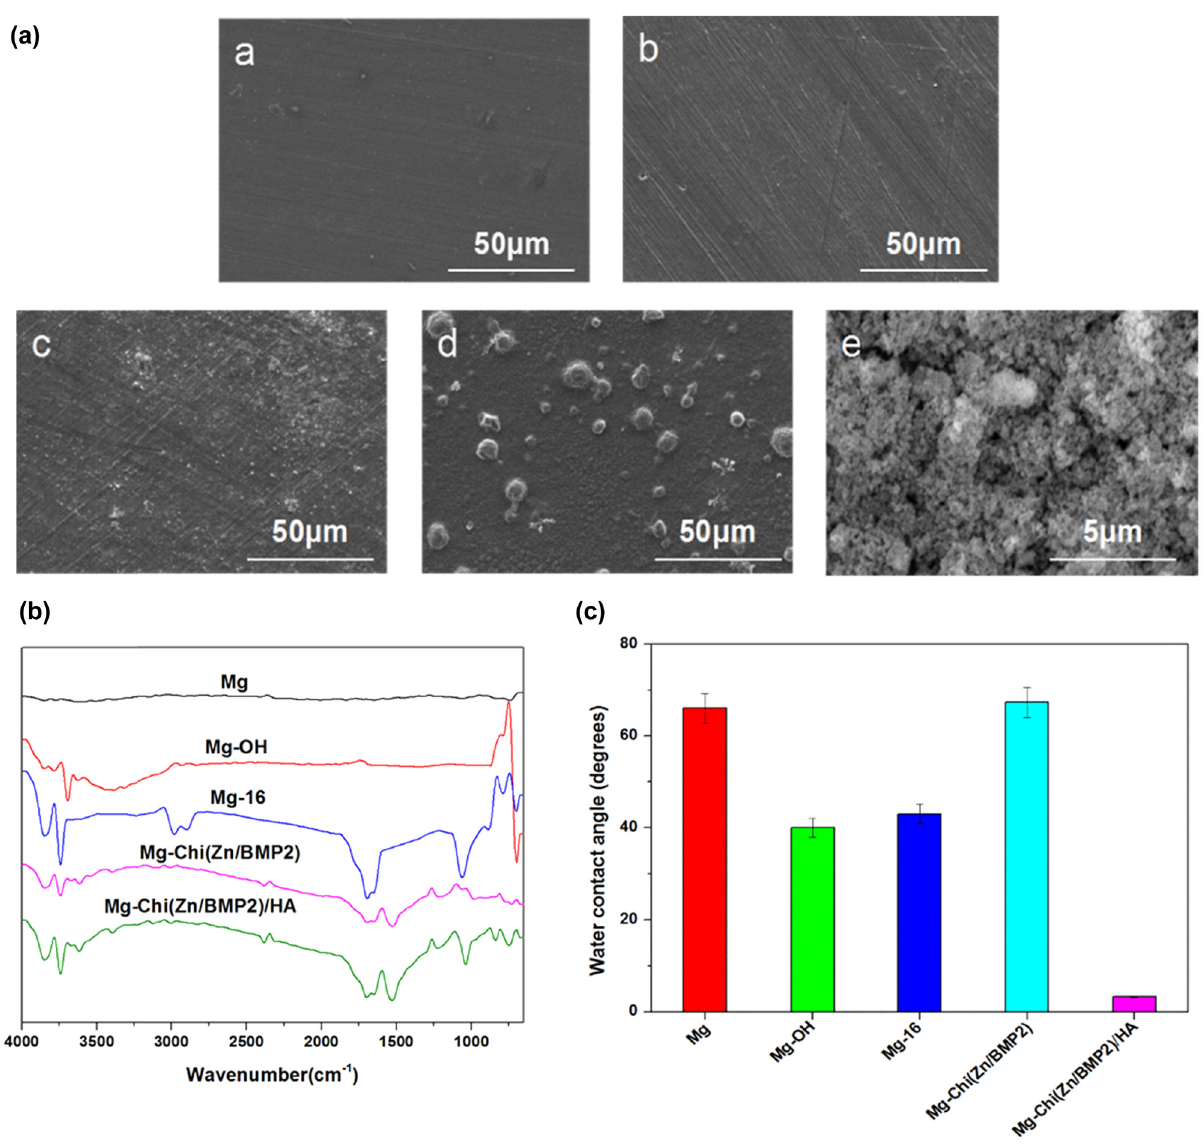
Figure 1: The representative SEM images (( a ) , Mg ( a ) , Mg - OH ( b ) , Mg - 16 ( c ) , Mg - Chi ( Zn/BMP2 ) ( d ) , Mg - Chi ( Zn/BMP2 ) /HA ( e )) , ATR - FTIR spectra ( b ) , and water contact angles ( c ) of the di ff erent